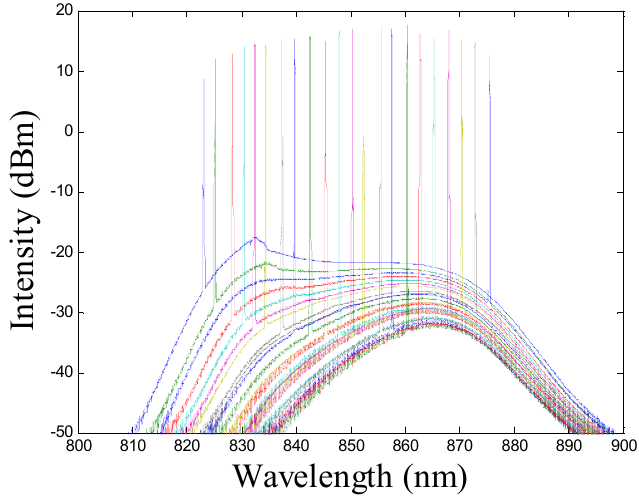
Figure 2. Swept source spectral bandwidth profile.